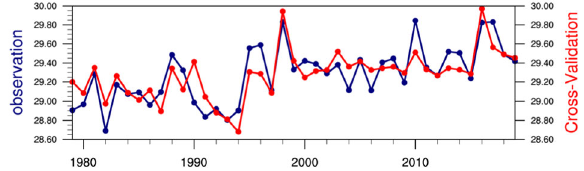
Fig. 5 Hindcast of the SWP SST-based prediction model. The observed (blue) and hindcasted (red) SST series (units: °C) of the TWP using the ten-fold cross-validation method (see Methods for details) for the period 1979 –